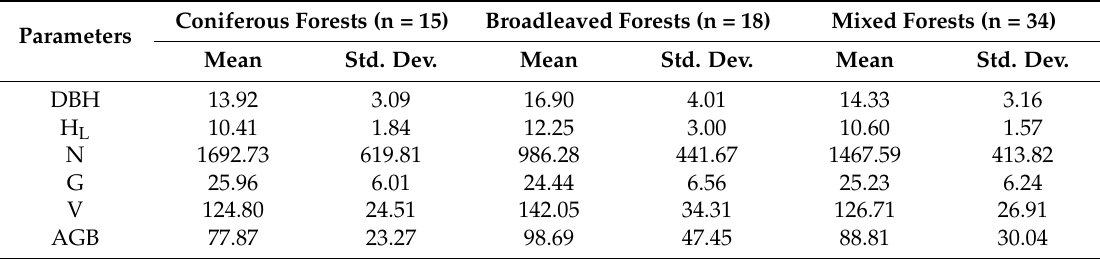
Table 1. Summary statistics of field-measured forest structural parameters in the study area (n = 67, size = 900 m 2 ).